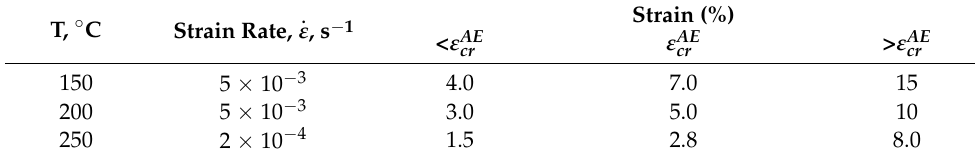
Table 2. Values of strain attained in the tests interrupted according to ε AE cr